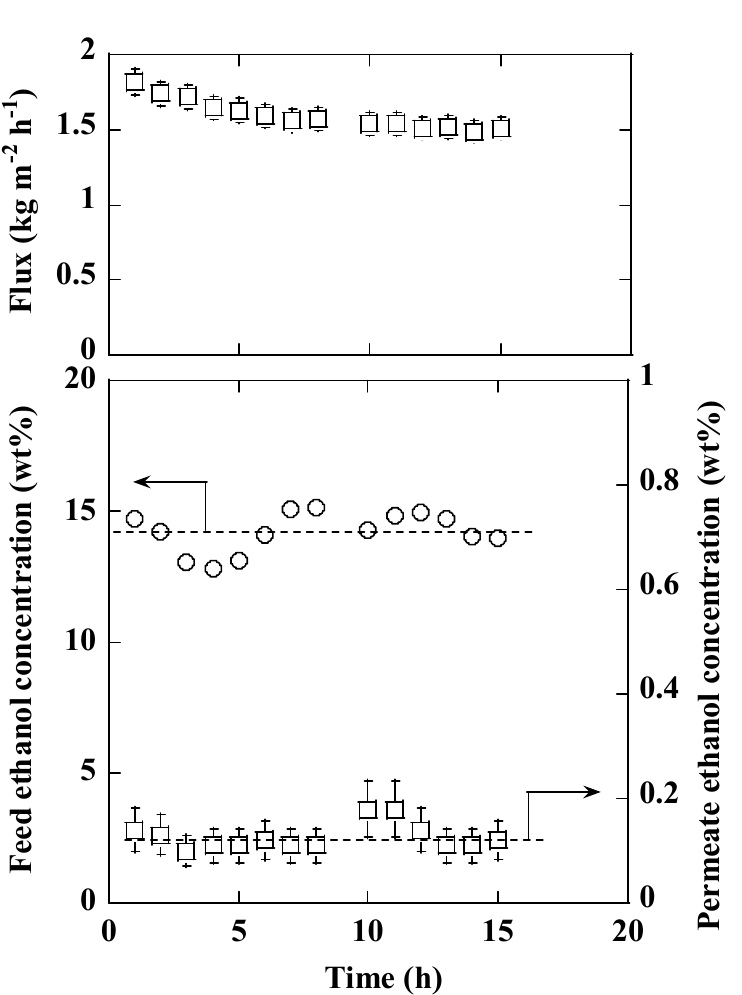
Figure 2. Membrane dehydration performance as a function of PV test time measured at 75 °C with a MFI zeolite membrane.